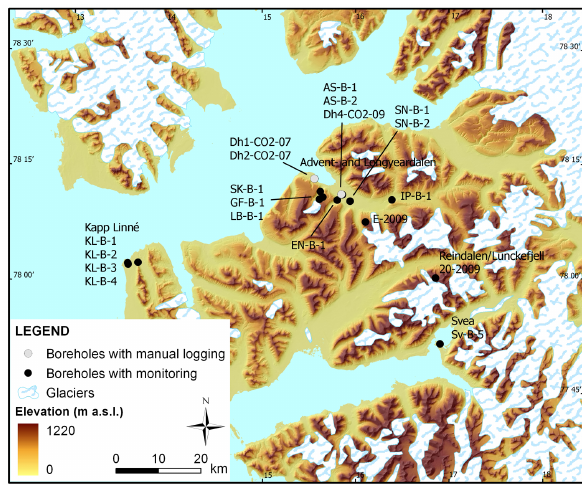
Figure 3. The Nordensk ¨ old Land Permafrost Observatory in Sval- bard with the position of the boreholes indicated. The Ny-Ålesund borehole is located outside the map. The borehole IDs refer to Ta- ble 2.